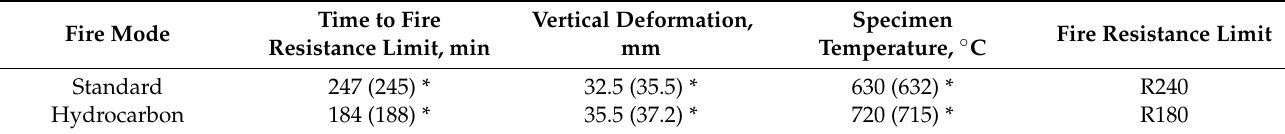
Table 5. Results of an experimental study, steel column.